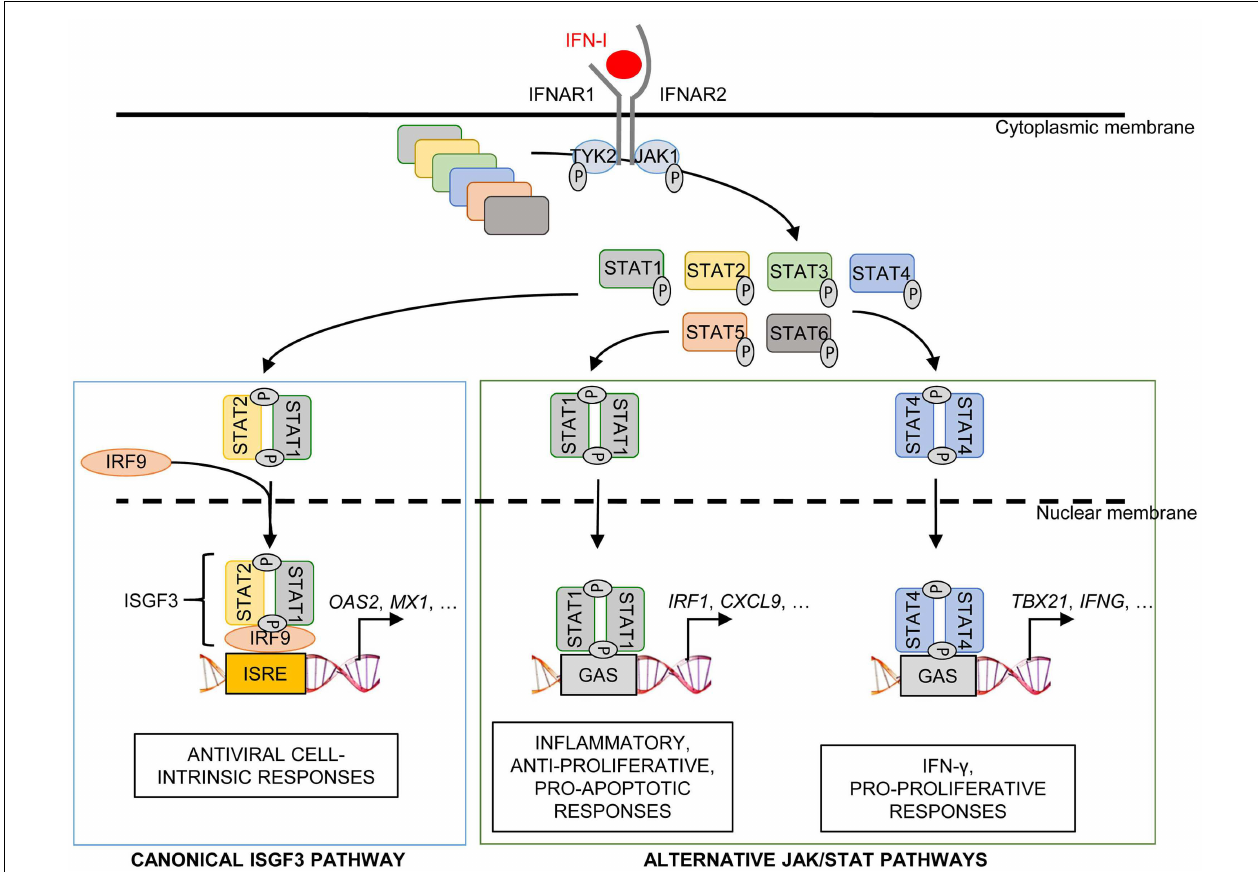
FIGURE 8 | Schematic representation of the ISGF3 and alternative JAK/STAT signaling pathways induced by IFN-I .The receptor for IFN-I, IFNAR, is composed of two chains, IFNAR1 and IFNAR2, which are respectively associated with the JAK family kinasesTYK2 and JAK1. IFN-I binding to IFNAR triggers the phosphorylation ofTYK2 and JAK1, which in turn phosphorylate a variety of STAT proteins. Activated STATs are able to form complexes, as homo- or hetero-dimers.The heterodimer STAT1-STAT2 binds to a third partner, IFN-regulatory factor 9 (IRF9), in order to form the ISGF3 complex.This complex translocates into the nucleus and binds to specific regulatory sequences, IFN-stimulated